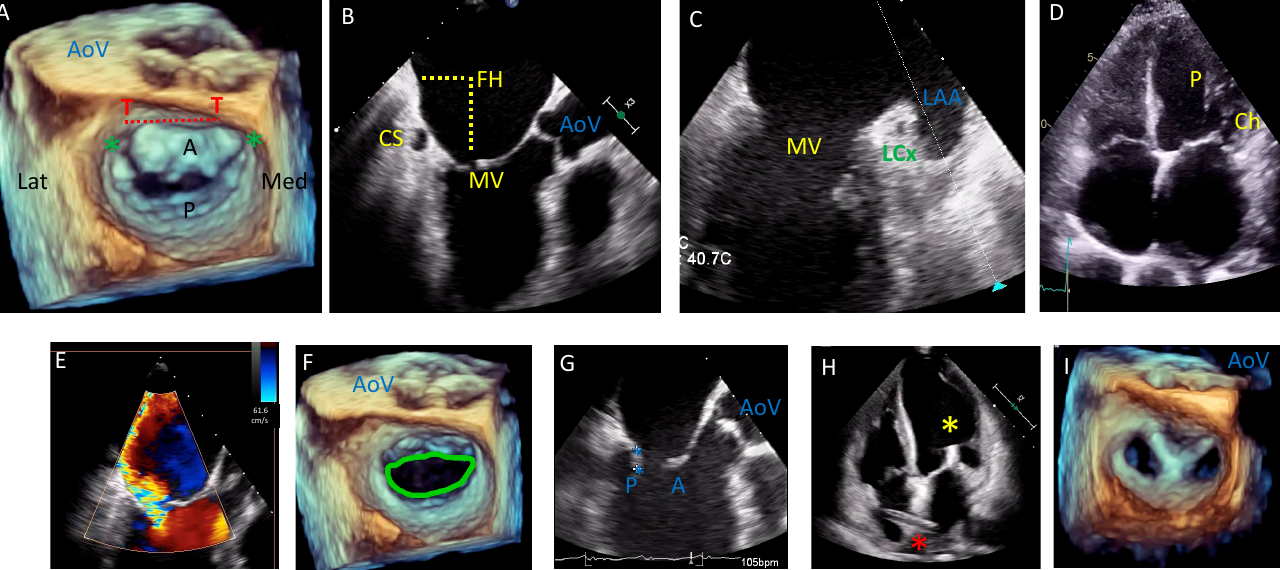
Figure 1. Transesophageal echocardiogram (TEE) pre-procedural assessment and intraprocedural guidance for a patient with severe secondary mitral regurgitation (MR) undergoing edge to edge repair. ( A ): mitral valve (MV) anatomy by 3D TEE showing the anterior leaflet (A) occupying one third of the annular perimeter and posterior leaflet (P) occupying two thirds. The anterior annulus